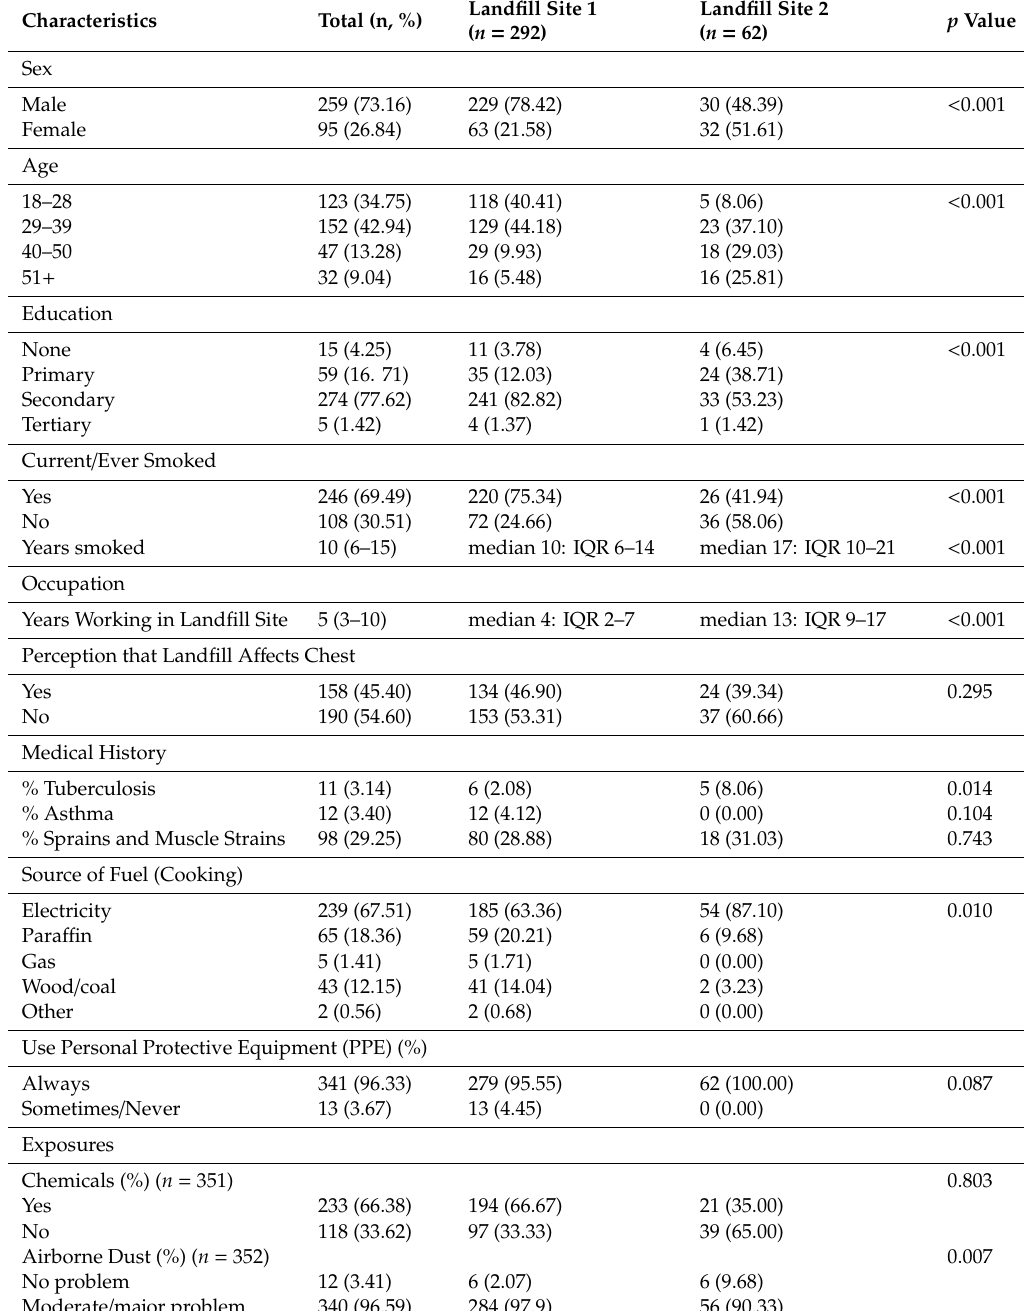
Table 1. Description of the socio-demographic characteristics of the study population and risk factors associated with respiratory